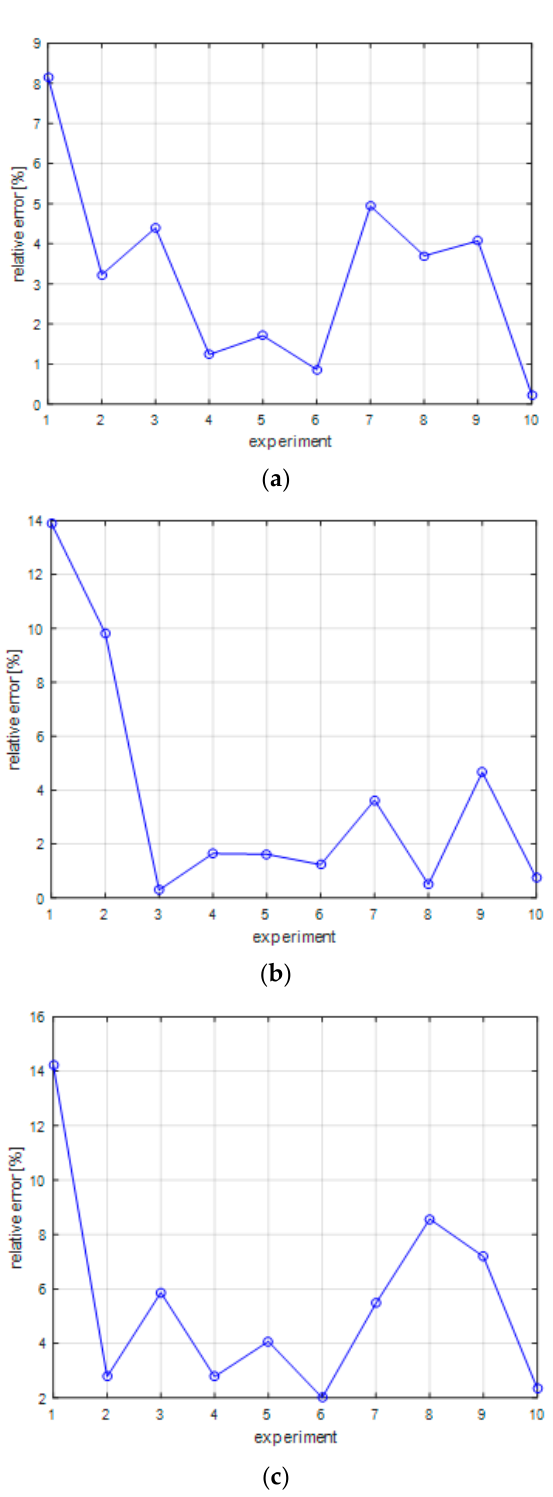
Figure 5. Comparison between Bioradar and Spirometer data for one sample of campaign test and each frequency. ( a ) Comparison at 2.1 GHz; ( b ) comparison at 2.4 GHz; ( c ) comparison at 2.6 GHz.